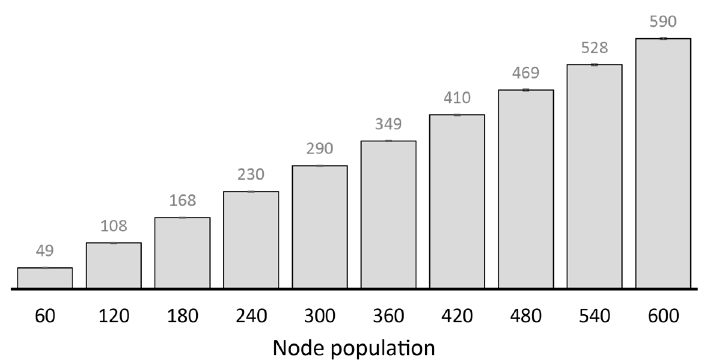
Figure 5. Transmission overhead under different node populations in the small scenario with PRoPHET (using no replication technique).